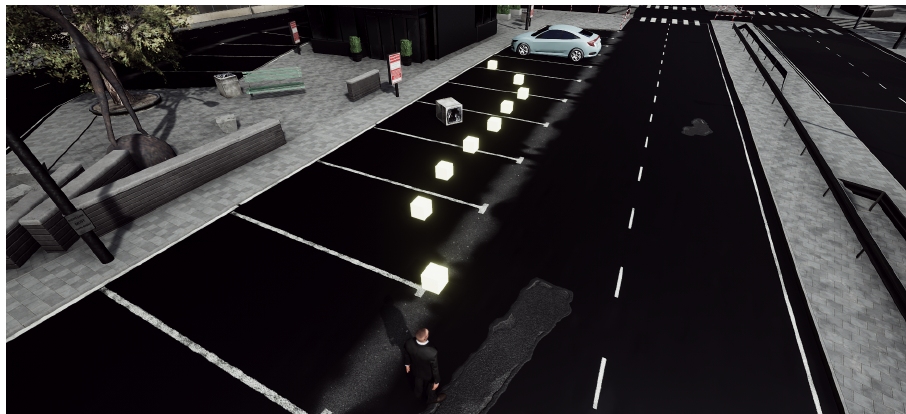
Figure 7. Path-planning task implementation